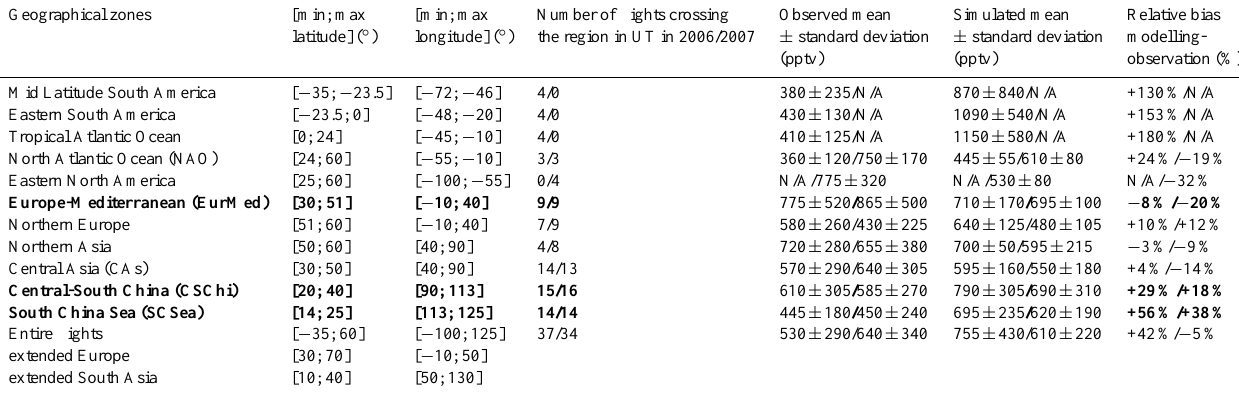
Table 2. Average and standard deviation are computed for all 2006 and 2007 flight segments included between the minimum and maximum longitude and latitude of the 11 geographical zones, exclusively in the troposphere, for co-located modelling results and observation. Standard deviation represents here the temporal and spatial variability. Number of flights crossing the geographical zones is also given for each year. Computations are similarly made for entire flights, independently the location. Coordinates are also given for the two extended geographical regions (Europe and South Asia), where budget terms are computed in Sect. 2. Bias is computed as observation subtracted from modelling results, divided by observation. Focus regions are showed in bold